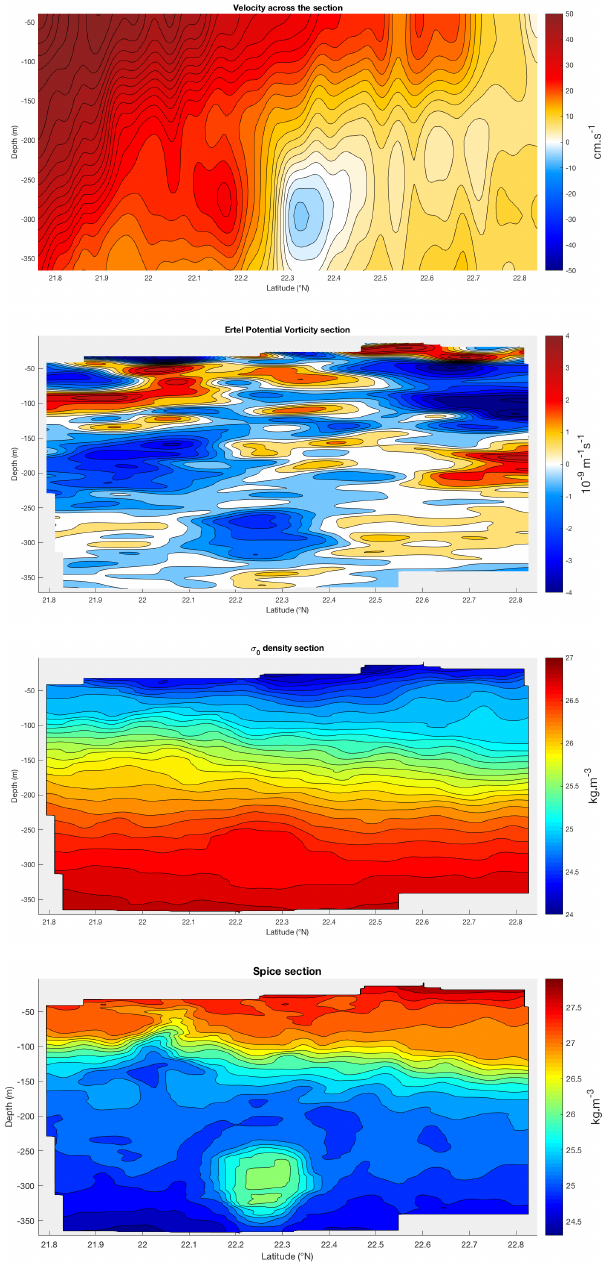
Figure 9. Sections across the lens off Ra’s Al Hadd, from the sur- face down to 350m depth. Measurements and derived quantities are VM-ADCP velocities, positive towards the north; the Ertel potential vorticity anomaly is derived from VM-ADCP and SeaSoar fields; σ 0 potential density and spice. The green cross profile from Fig. 8 is taken in the core of this lens.